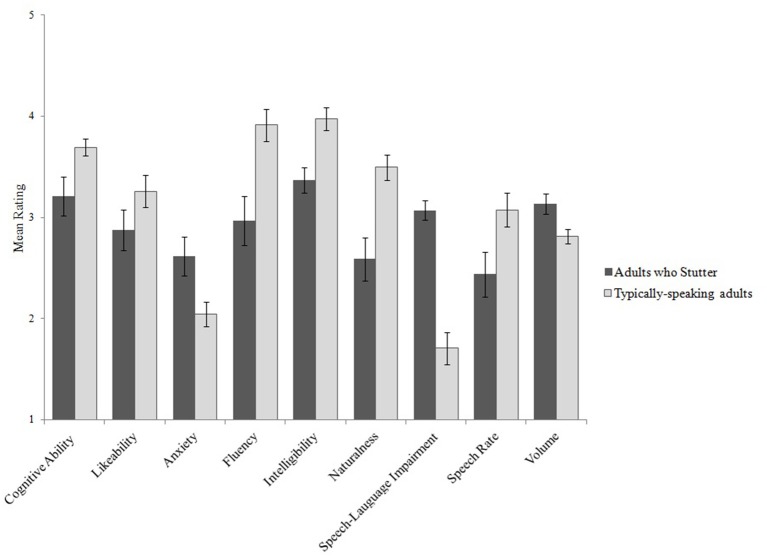
Mean ratings from Experiment 1 for each measure for adults who stutter and typically-speaking adults. Error bars indicate ±1 SEM. Higher ratings indicate greater cognitive ability, more likeable, greater anxiety, greater fluency, increased intelligibility, increased naturalness, greater likelihood of a SLI, faster speech rate, and increased volume.